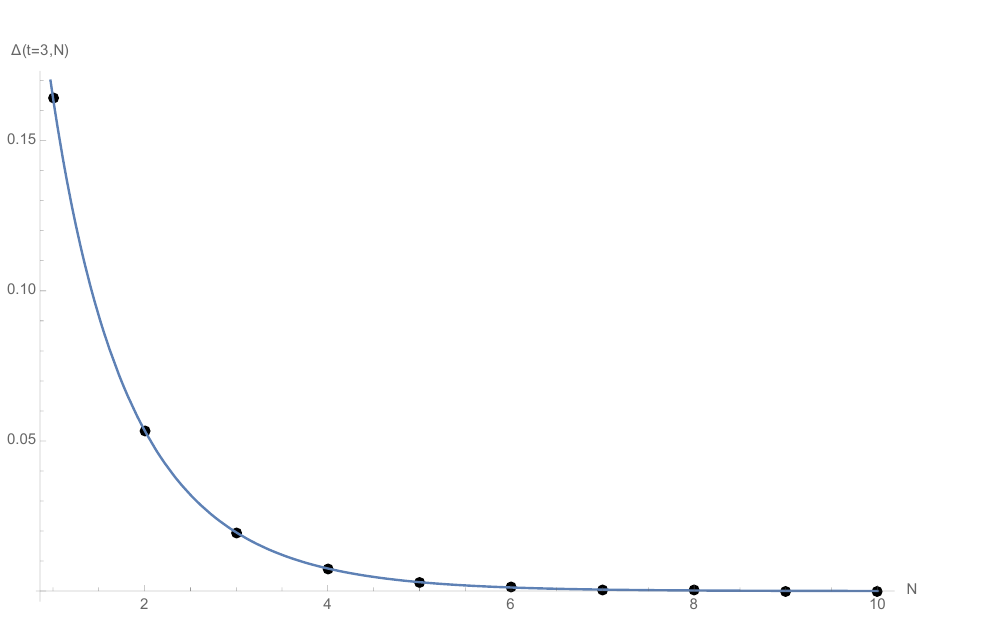
Figure 10 . The N dependence of the leading large N contribution J N ( N=t ) in (5.32) in the strong coupling regime, plotted here as the solid blue curve for t = 3. The black dots are the exact values from the determinant expression (4.1) for (cid:1)( t; N ). Notice that the agreement appears to